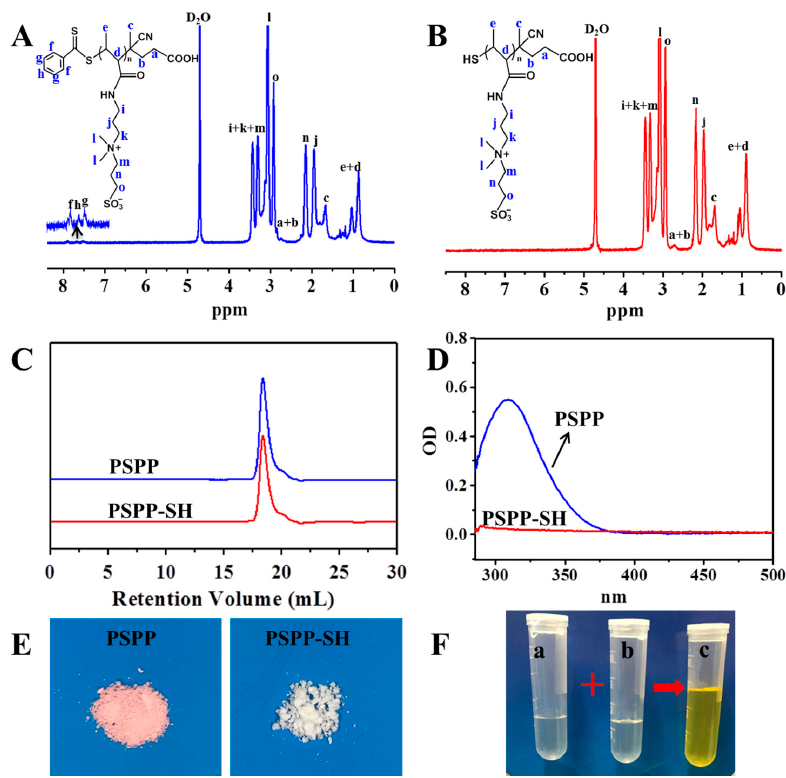
Figure 2. Characterization of PSPP and PSPP-SH. 1 H NMR spectra of ( A ) PSPP and ( B ) PSPP-SH. ( C ) gel permeation chromatography (GPC) elution profiles (refractive index, R.I.). ( D ) UV spectra in deionized water at the polymer concentration of 0.25 mg/mL. ( E ) Digital photos of PSPP and PSPP-SH. ( F ) Digital photos of (c) Alman ’ s color reaction result of (a) 5,5 ′ -dithiobis(2-nitrobenzoic acid) (DTNB) and (b) PSPP-SH in phosphate buffer (pH 8.0).